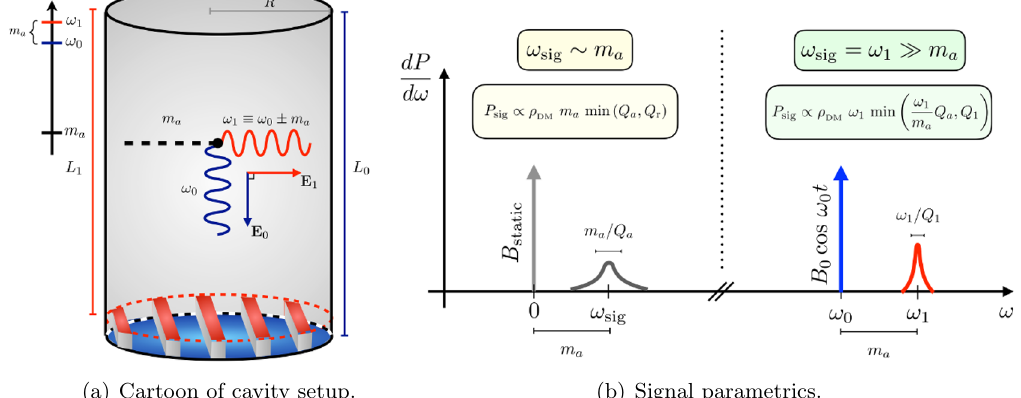
Figure 1 . (a) A schematic depiction of a potential cavity setup. A photon of frequency ! converted by the axion dark matter background into a photon of frequency ! 0 (cid:6) m a , where m a is the axion mass. The cavity is designed to have two nearly degenerate resonant modes at ! 0 and ! 1 = ! 0 + m a . One possibility, as discussed in section 4, is to split the frequencies of the two polarizations of a hybrid HE 11 p mode in a corrugated cylindrical cavity. These two polarizations e(cid:11)ectively see distinct cavity lengths, L 0 and L 1 , allowing ! 0 and ! 1 to be tuned independently. In this case, larger frequency steps could be achieved by adjusting the (cid:12)ns (shown in red), while smaller frequency steps could be achieved with piezo-actuator tuners. (b) A schematic comparison between the proposed frequency conversion scheme (right of the dotted line) and typical searches using static magnetic (cid:12)elds (left of the dotted line). The vertical and horizontal axes correspond to di(cid:11)erential power and frequency, respectively, of either the driven (cid:12)eld (vertical arrows) or the axion-induced signal (resonant curves). The parametric signal power derived in section 2 is shown for both setups, where we assume ! sig (cid:24) V (cid:0) 1 = 3 for our proposed scheme and factored out a common volume dependence of V 5 = 3